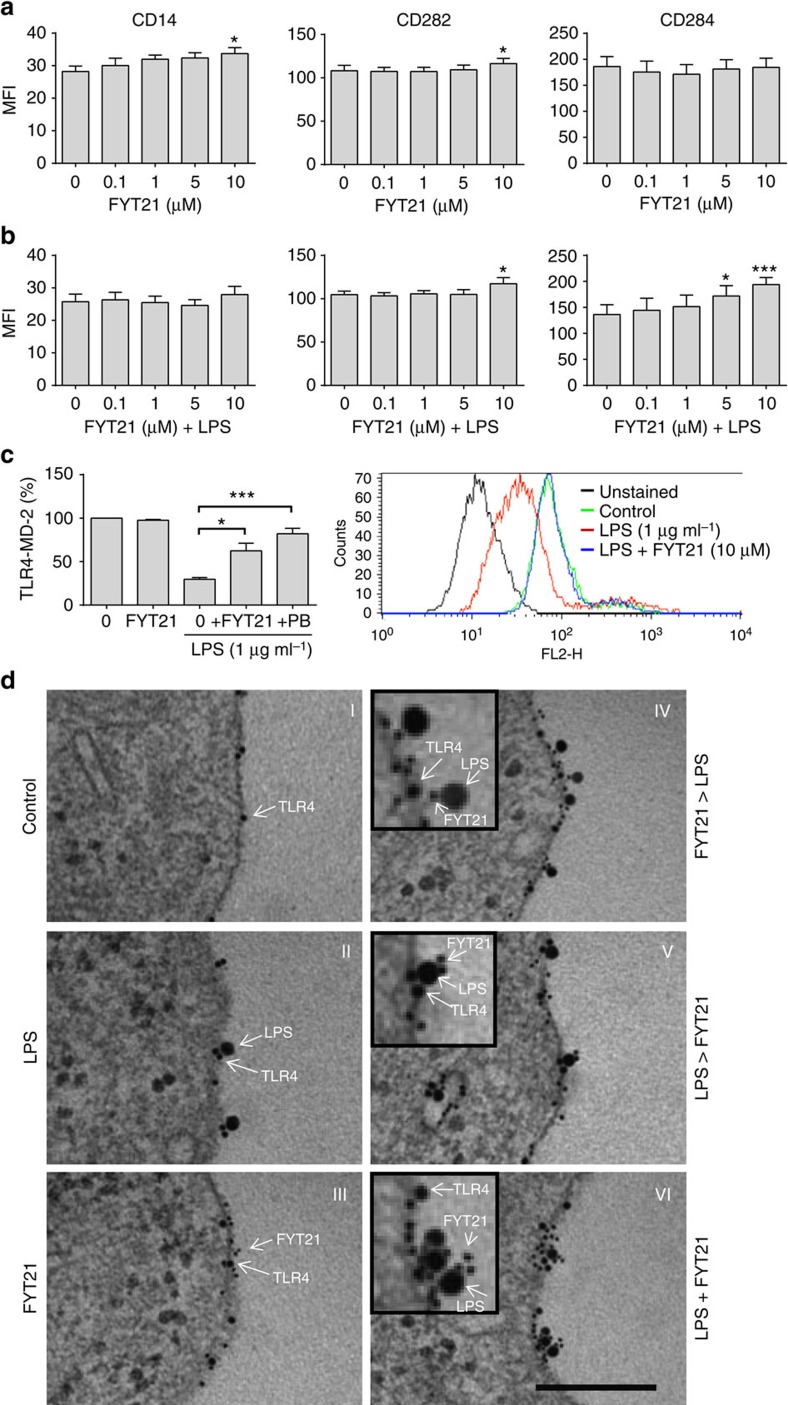
FYT21 inhibits TLR4 dimerization induced by LPS.THP1 cells were incubated o/n with a range of FYT21 without (a) or with (b) 100 ng ml−1 of LPS, and the expression of CD14, CD282 (TLR2) and CD284 (TLR4) was measured on a FACSCalibur. Results, expressed as mean fluorescence intensity (MFI), are means±s.e.m. of eight experiments. (c) The expression of monomeric TLR4 on RAW-Blue cells, as compared with dimerized/LPS-bound TLR4 (n=4), using an antibody that only binds to the monomeric form. A representative FACS histogram is shown to the right. Results of control samples were set at 100%. The effect of 10 μM FYT21 or 50 μg ml−1 of polymyxin B on LPS-induced TLR4 activation are expressed as a percentage relative to the control. Results are means±s.e.m. of four experiments. Values are significantly (*P<0.05 and ***P<0.0005) different from the controls as analysed using a one-way ANOVA with a Dunnett's multiple comparisons test. (d) Cells were incubated with LPS and/or FYT21 for 30–60 min followed by processing and Au-labelling with antibodies against TLR4, LPS and FYT21: (I) monomeric TLR4, (II) LPS-induced dimerization of TLR4, (III) binding of FYT21 to the membrane, (IV) the interaction between FYT21, LPS and TLR4 when the cells were preincubated for 30 min with FYT21 or (V) LPS, or when added simultaneously (VI; scale bar, 200 nm).